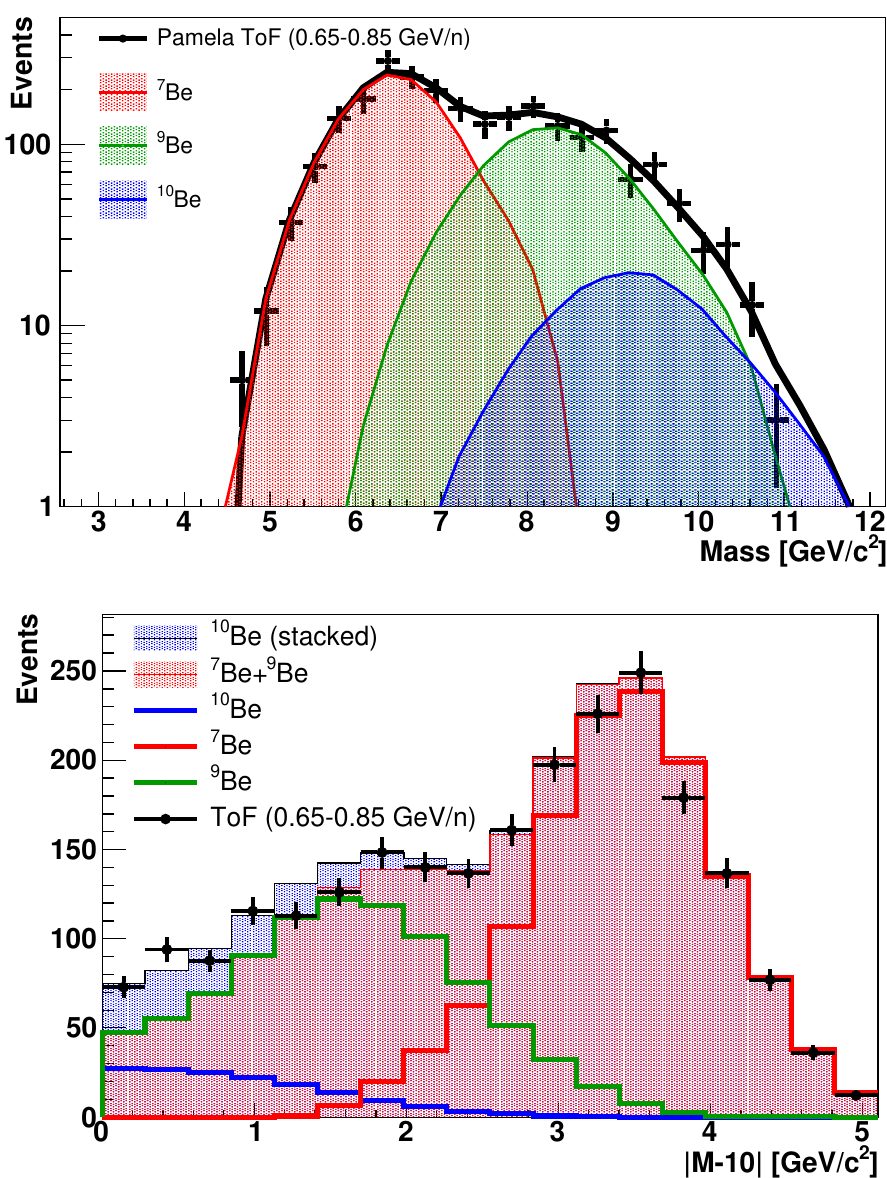
Figure 5. An example of beryllium isotope measurements with the data-driven analysis of PAMELA- ToF data collected in the 0.65–0.85 GeV/n range. The black continuous line is the sum of the three beryllium components. In the bottom plot the same data are shown as a function of | M − 10 | l this allows one to stack the 10 Be contribution (blue filled) over the 7 Be + 9 Be (red